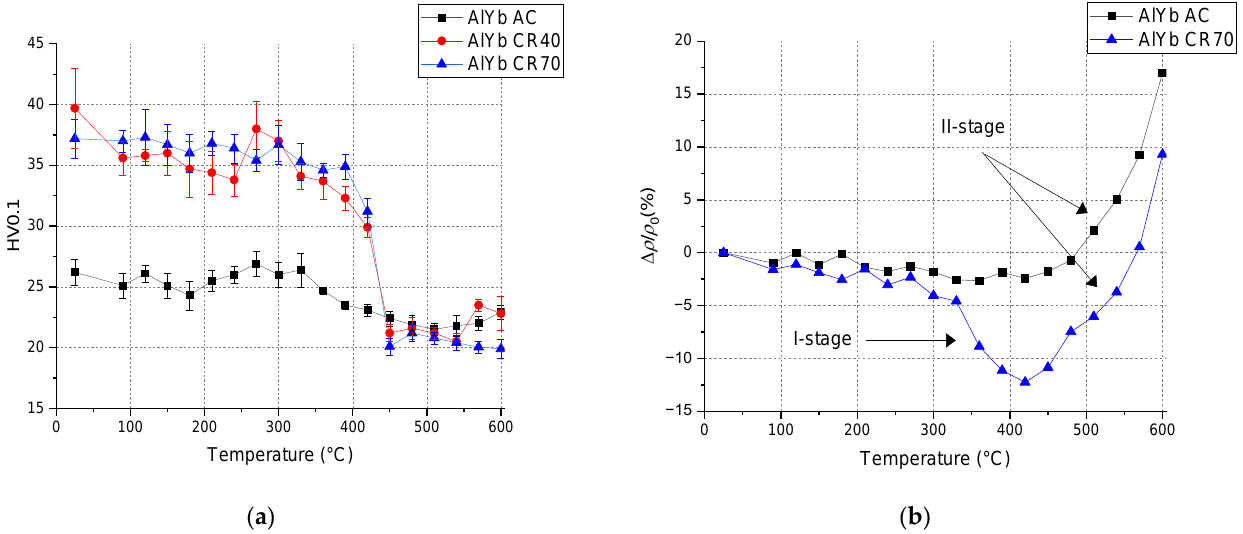
Figure 5. Isochronal ageing curves of the ( a ) microhardness HV0.1 changes and ( b ) relative resistivity changes in AlYb AC and CR alloys.